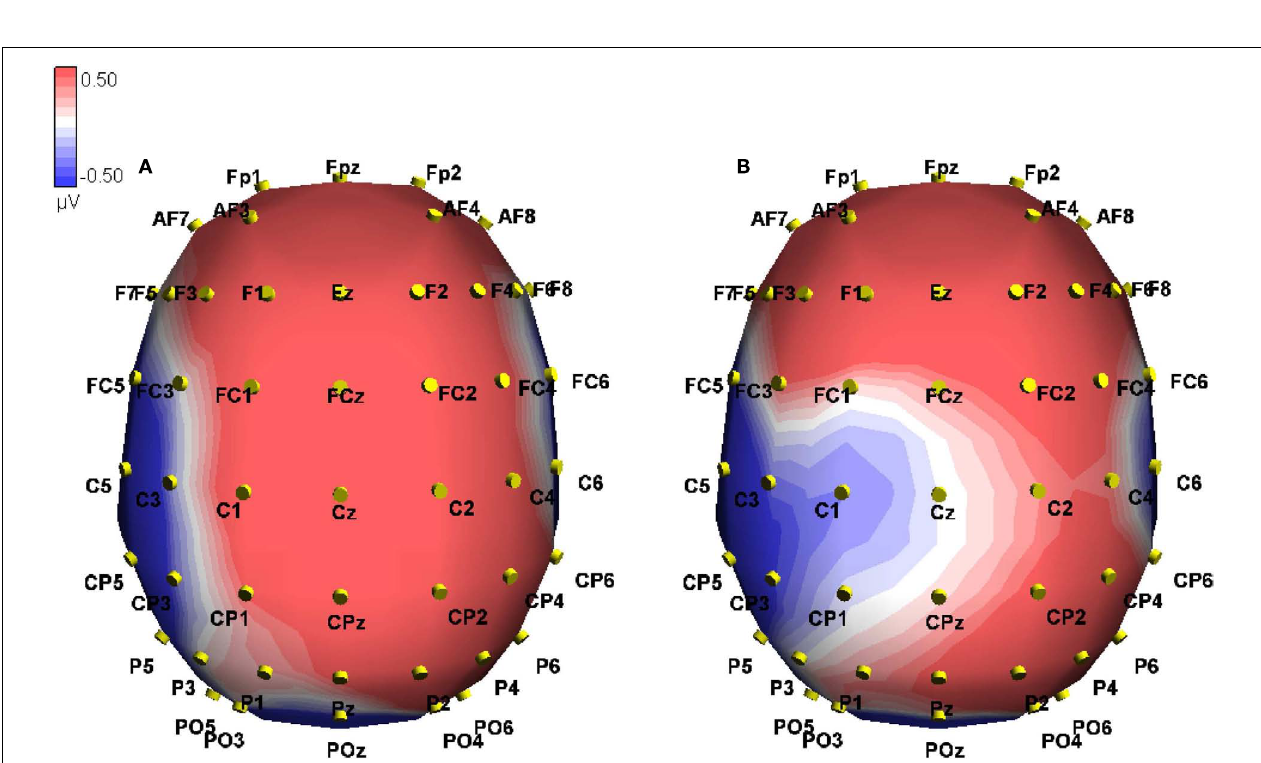
FIGURE 2 | Event-related potential traces for false sentences for nine selected sites across the scalp, time locked to onset of the critical word (presented at 0ms). Negative activation is plotted up.The blue lines show